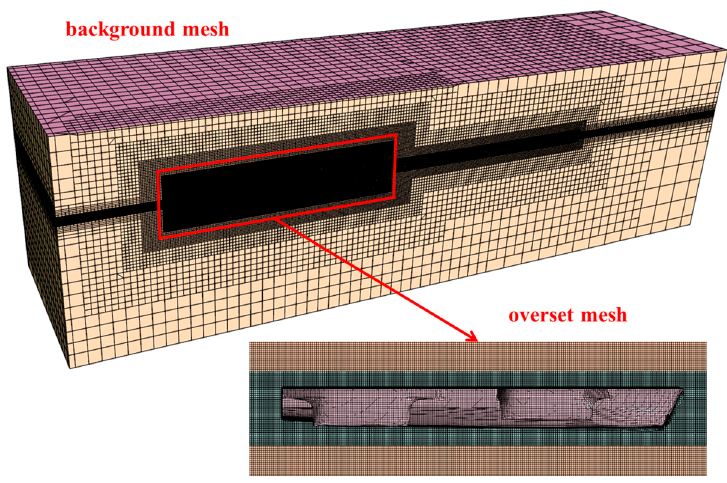
Figure 6. The background mesh and overset mesh of the pentamaran in the wave condition.